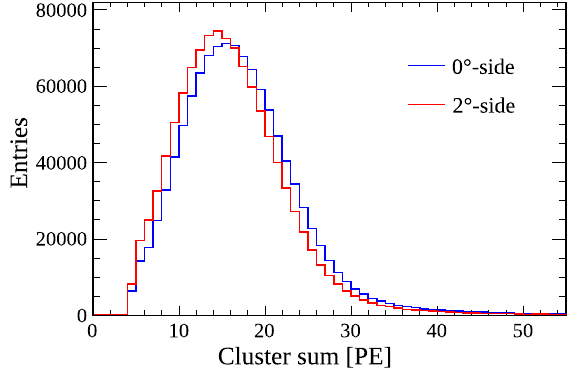
FIG. 6. Cluster sum distribution in the two detection planes of a four-layer BGV SciFi module. The measurement was performed with the nominal SiPM overvoltage Δ V ¼ 3 . 5